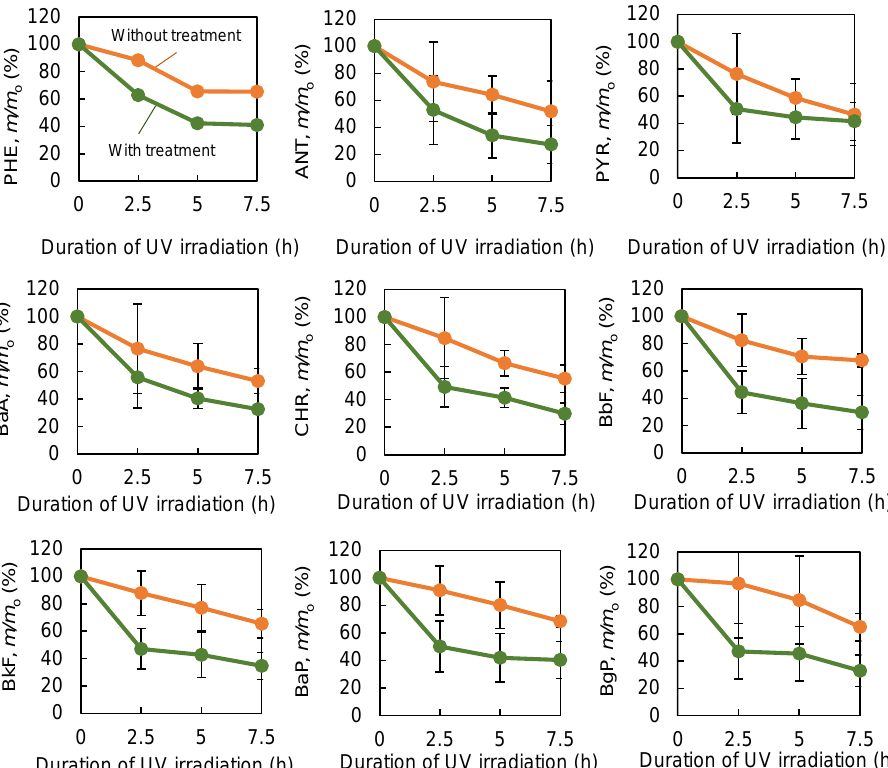
Figure 7. UV-induced degradation of PAHs in PM 2.5 collected on TiO 2 filters with and without water treatment to remove co-existing water-soluble salts. Plots show the averages of three samples and the error bars show the standard